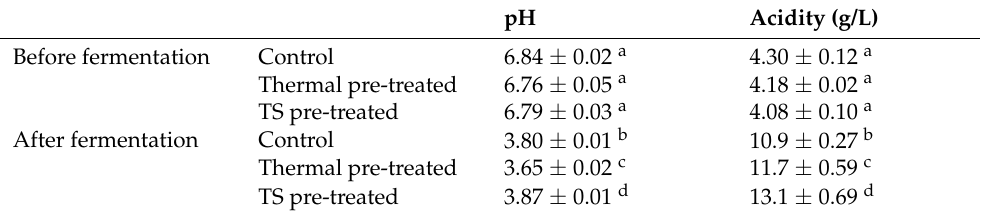
Table 1. Effects of thermal or thermosonication treatments of broccoli florets on changes in pH and titratable acidity in broccoli purees before and after lactic acid